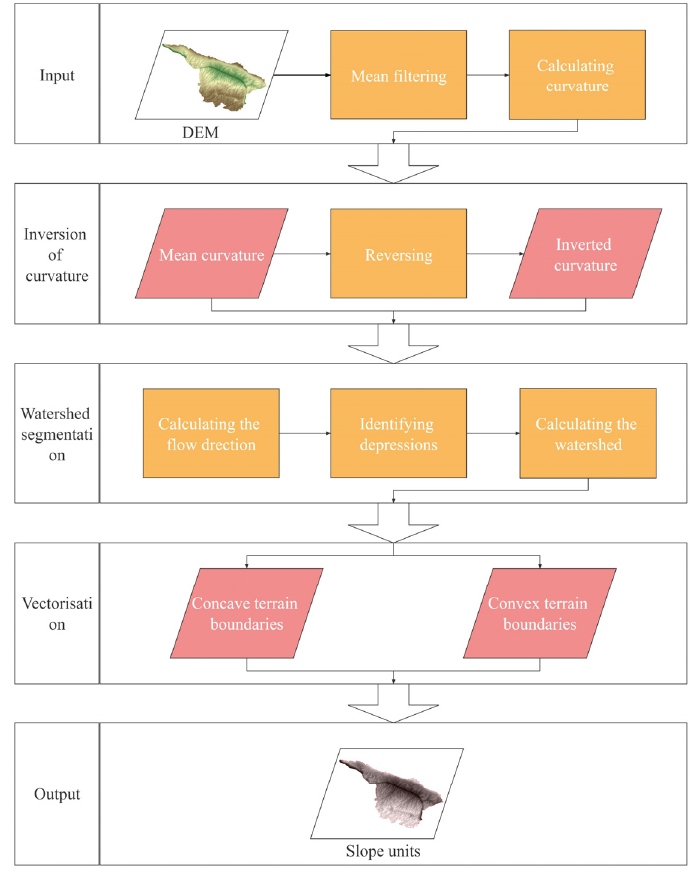
Figure 2. Flow chart of slope unit division.